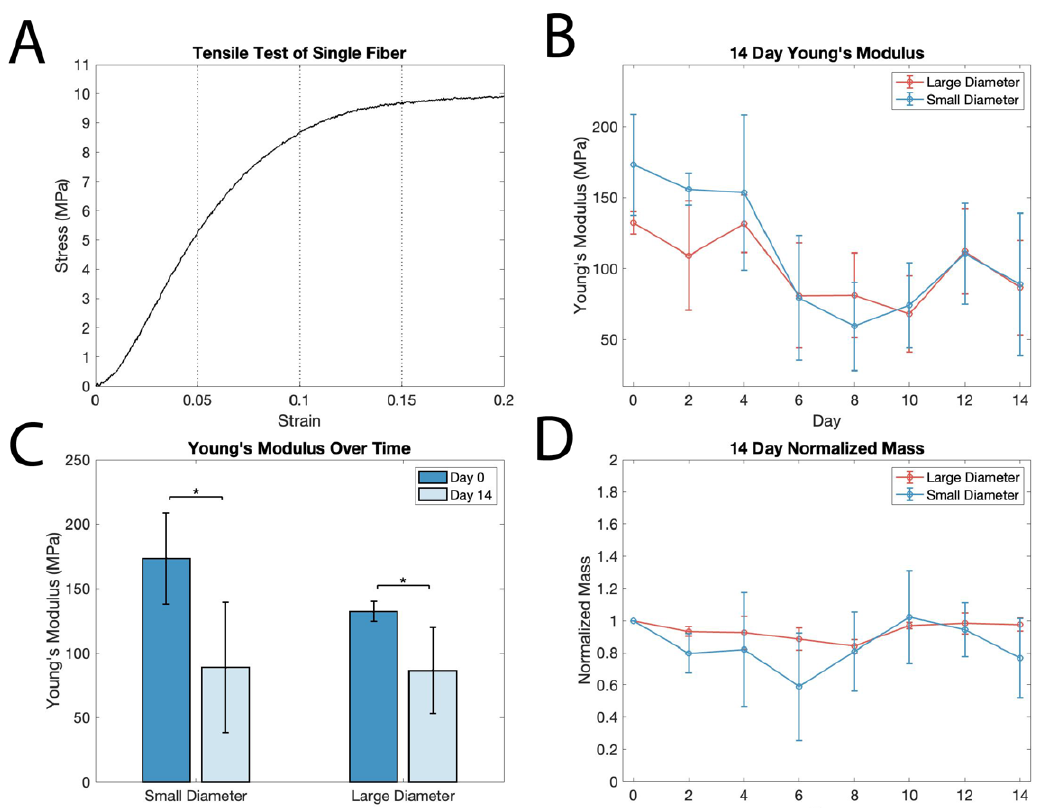
Figure 3. Single-fiber mechanics during degradation show decreases in stiffness but retention of mechanical integrity throughout 2 weeks incubation in salt solution. ( A ) Representative stress–strain curve of a single-fiber tensile test, with bins from 0 to 5%, 5 to 10%, 10 to 15%, and 15 to 20% strain denoted by vertical dotted lines. ( B ) Young’s modulus of small and large fibers at 0–5% strain over a 14-day period in PBS solution ( n = 5 samples for each time point). ( C ) Young’s modulus of small and large fibers compared at days 0 and 14 (* indicates p ≤ 0.05). ( D ) Mass of small and large fibers over 14 days in PBS solution, normalized to initial mass ( n = 5 samples for each time point; n.s.).